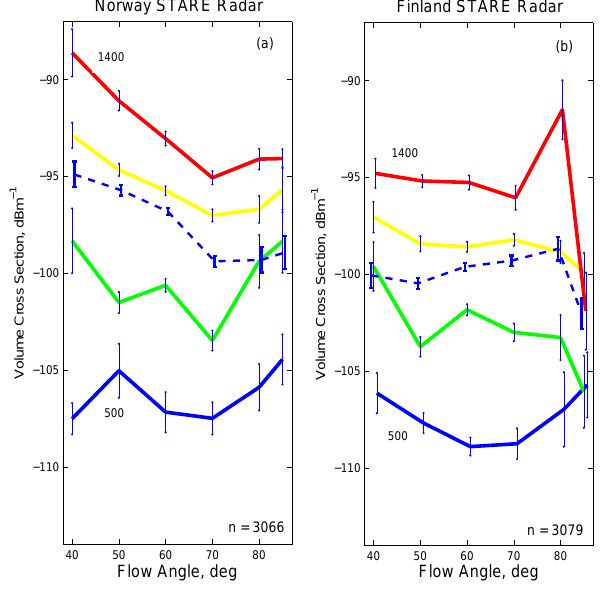
Fig. 4. (a) The Norway and (b) Finland radar VCS dependence upon the flow angle for various mean electron drift velocities. The measured VCSs were grouped into six 10 ◦ -bins of the flow angle centred at 40 ◦ , 50 ◦ , 60 ◦ , 70 ◦ , 80 ◦ and 85 ◦ and averaged over four intervals of the electron drift velocity centred at 500, 700, 1000 and 1400ms − 1 , blue, green, yellow and red lines, respectively. Dashed line shows the flow angle dependence without binning according the electron drift velocity. Vertical bars are error estimates for the average values.